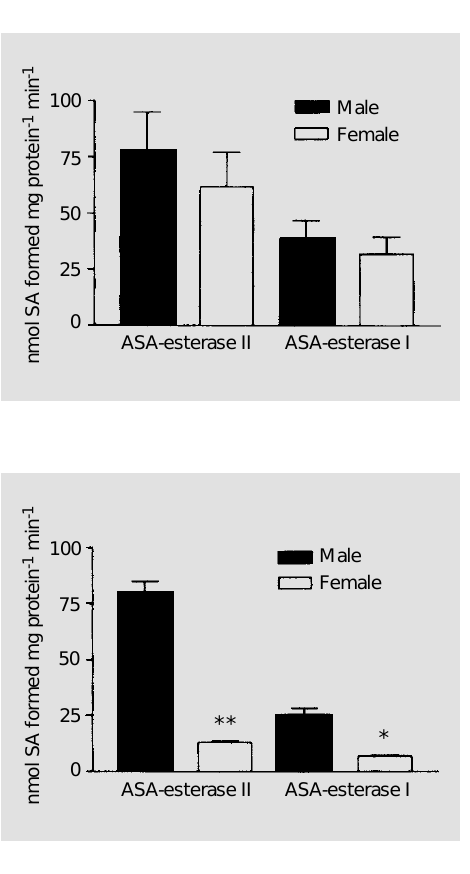
Figure 1 - ASA-esterases I and II activities in liver homogenates from male and female mice. The final ASA concentration in the assay was 8 mM. Results are reported as mean ± SD. N = 5 for all groups.